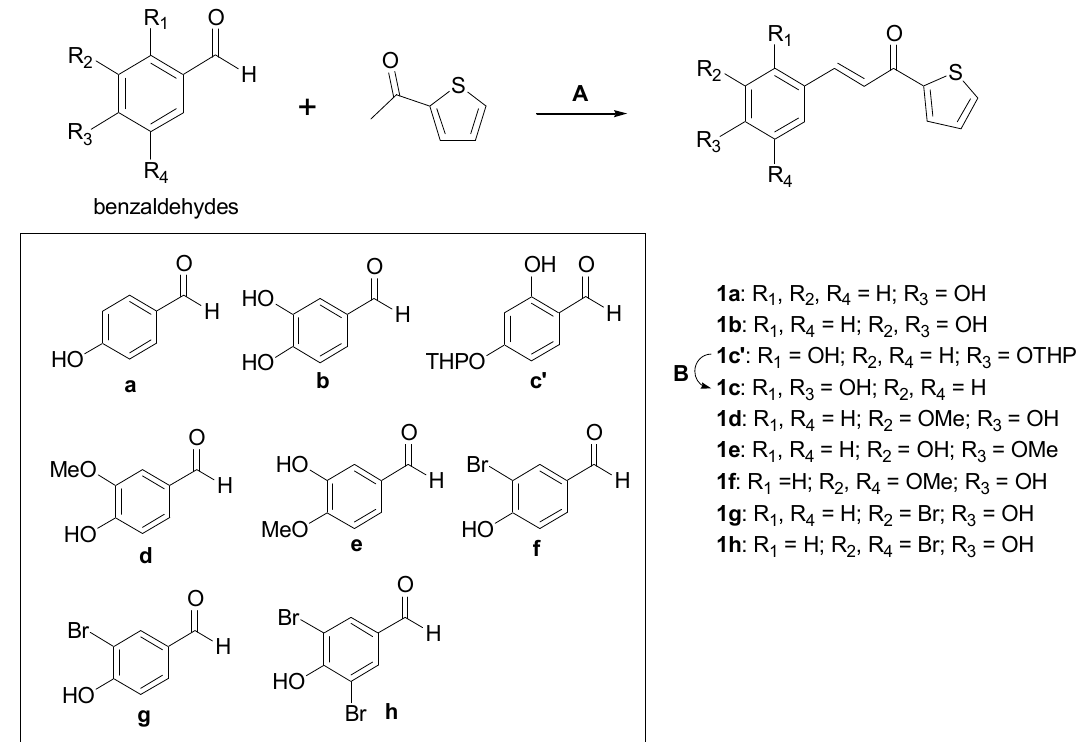
Scheme 1. Synthetic scheme for the target compounds 1c – h . Reagents and conditions: ( A ) 1.0 M